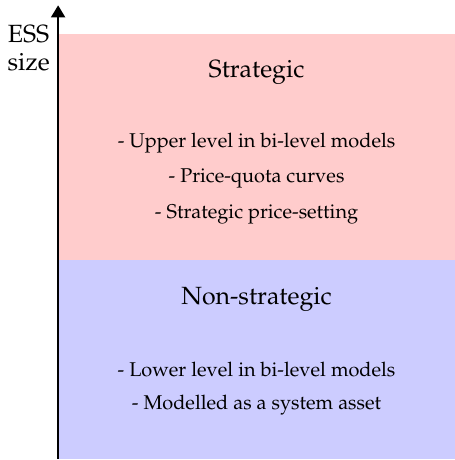
Figure 1. Modelling approaches to strategic and non-strategic ESSpresented in this